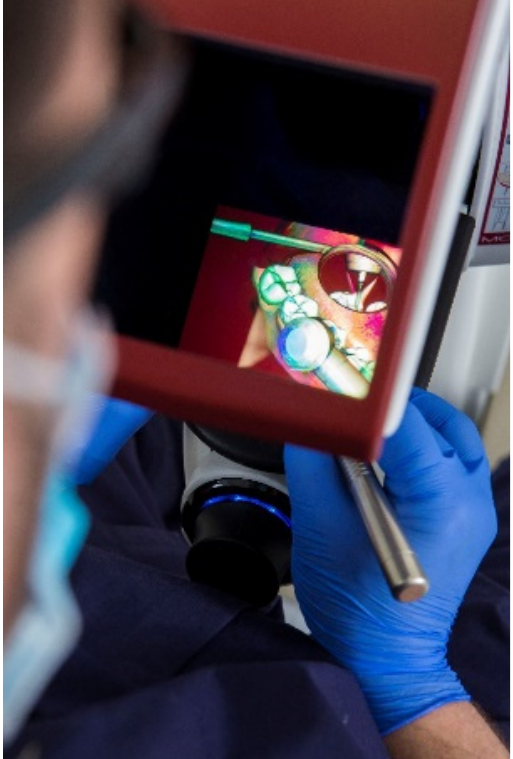
Figure 1. Simodont ® dental trainer. Source: Courtesy of the authors. Written permission of NISSIN Dental.